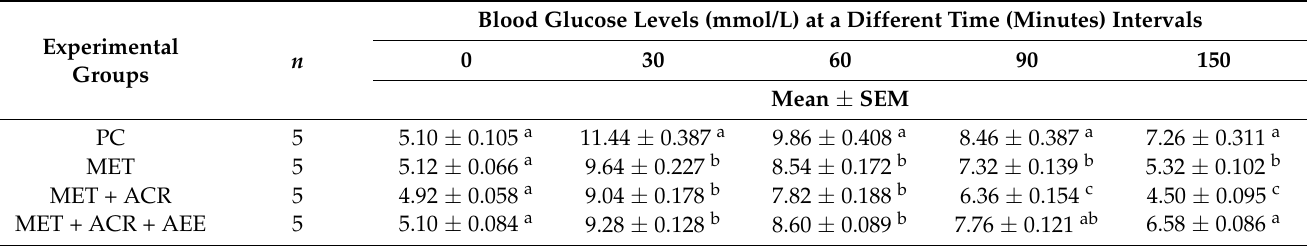
Table 1. Effects of therapeutic doses of different drugs either alone or in combination in mice model.